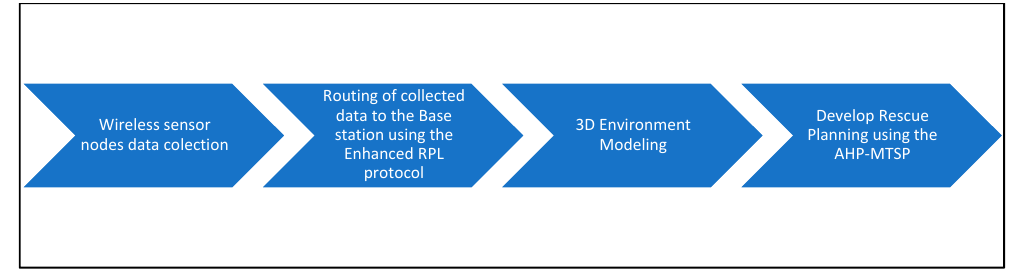
Figure 1. System Flow Chart.